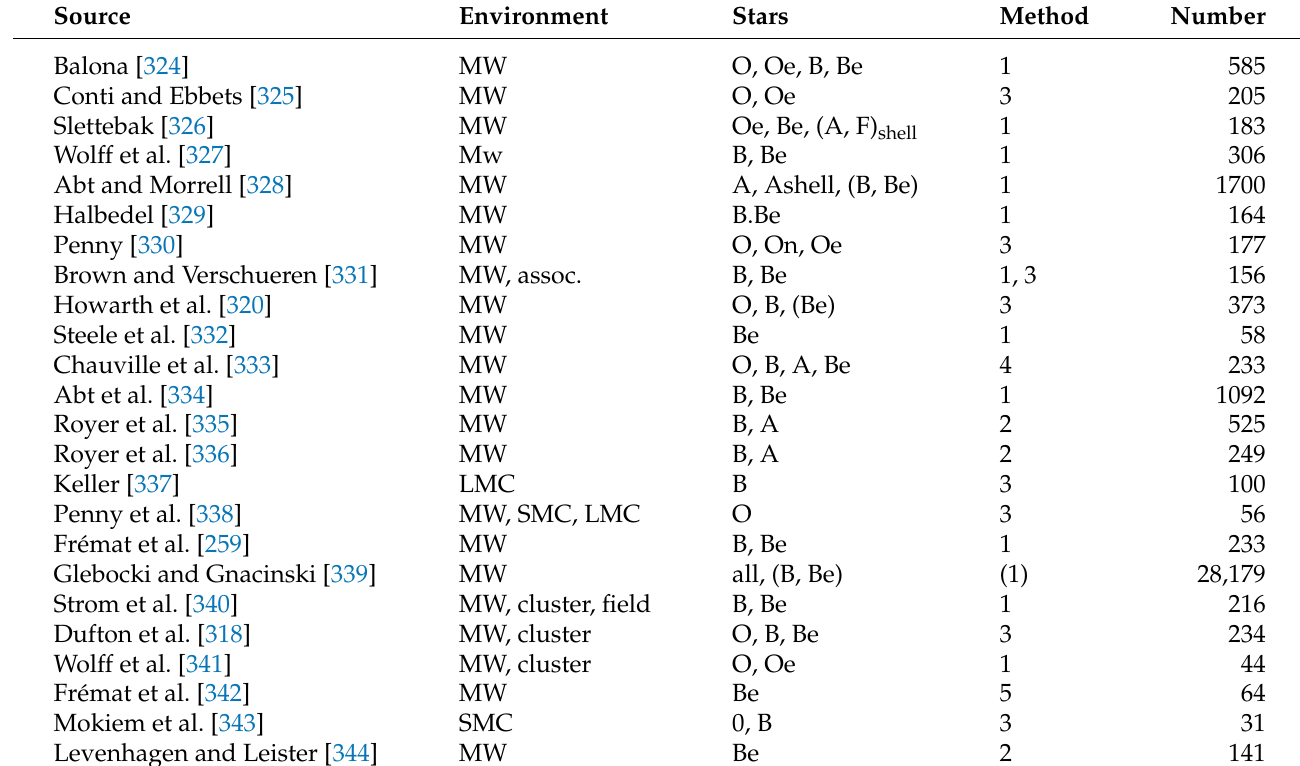
Table 1. Non-exhaustive table of V sin i determinations for early-type